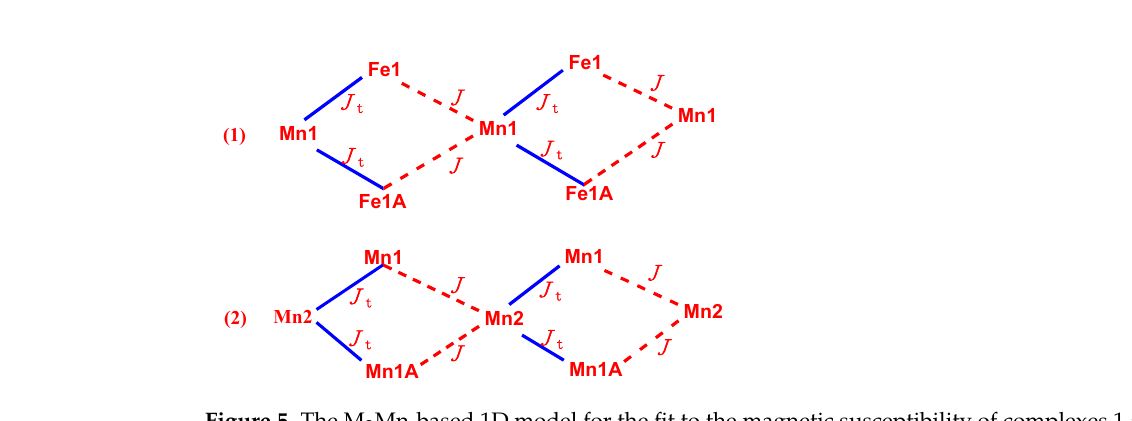
Figure 5. The M 2 Mn-based 1D model for the fit to the magnetic susceptibility of complexes 1 and 2 (M = Fe or Mn). The best-fit parameters are g = 2.017(8) and J = − 0.066(2) cm − 1 for complex 1, and g =